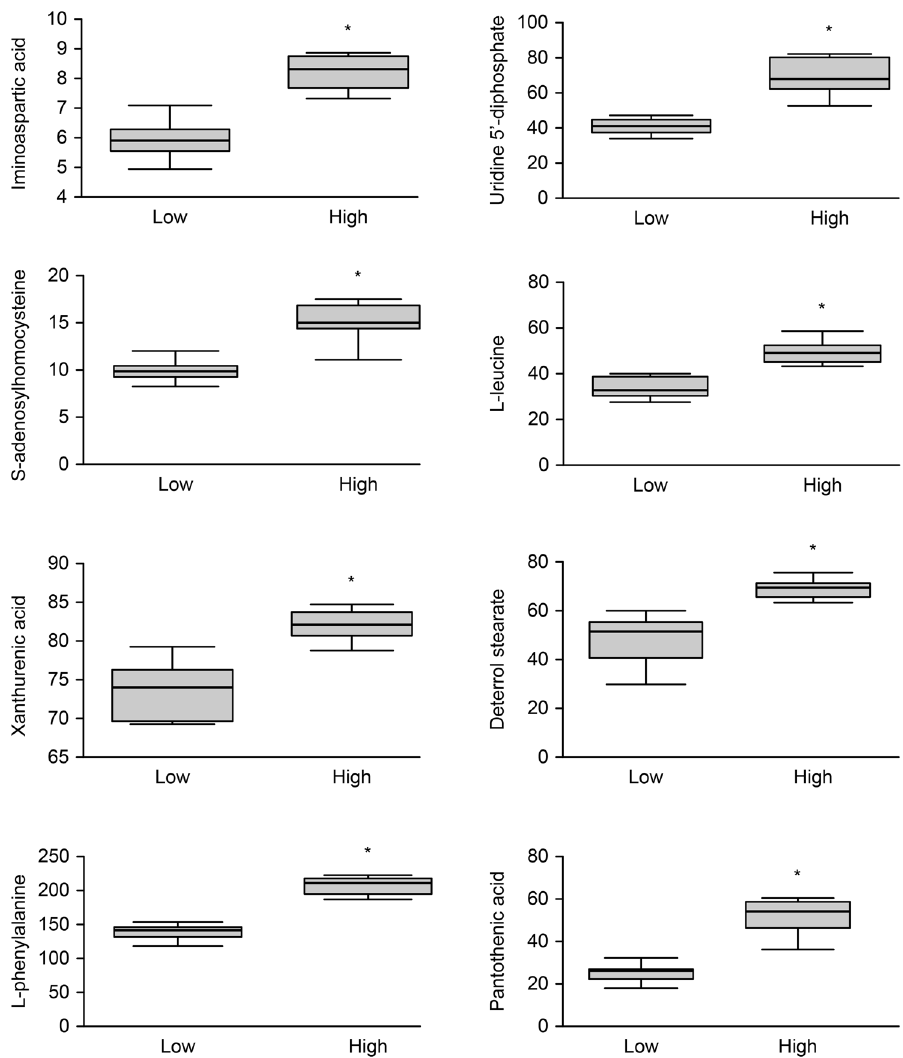
Figure 3. Metabolite profiles obtained from the quantitative analysis of the subjects. The figure was obtained in the same manner as Fig. 2. The differences in iminoaspartic acid, pantothenic acid, L-phenylalanine, L-leucine, deterrol stearate, xanthurenic acid, uridine 5 ′ -diphosphate, and S-adenosylhomocysteine between the LA and HA are displayed. “ * ” indicates P <